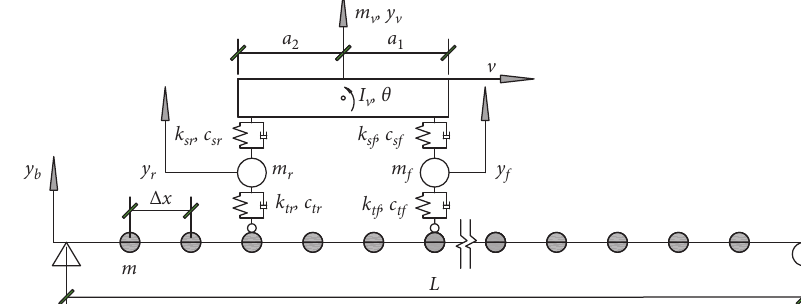
Figure 11: A 4-DOF model of the vehicle-bridge interaction